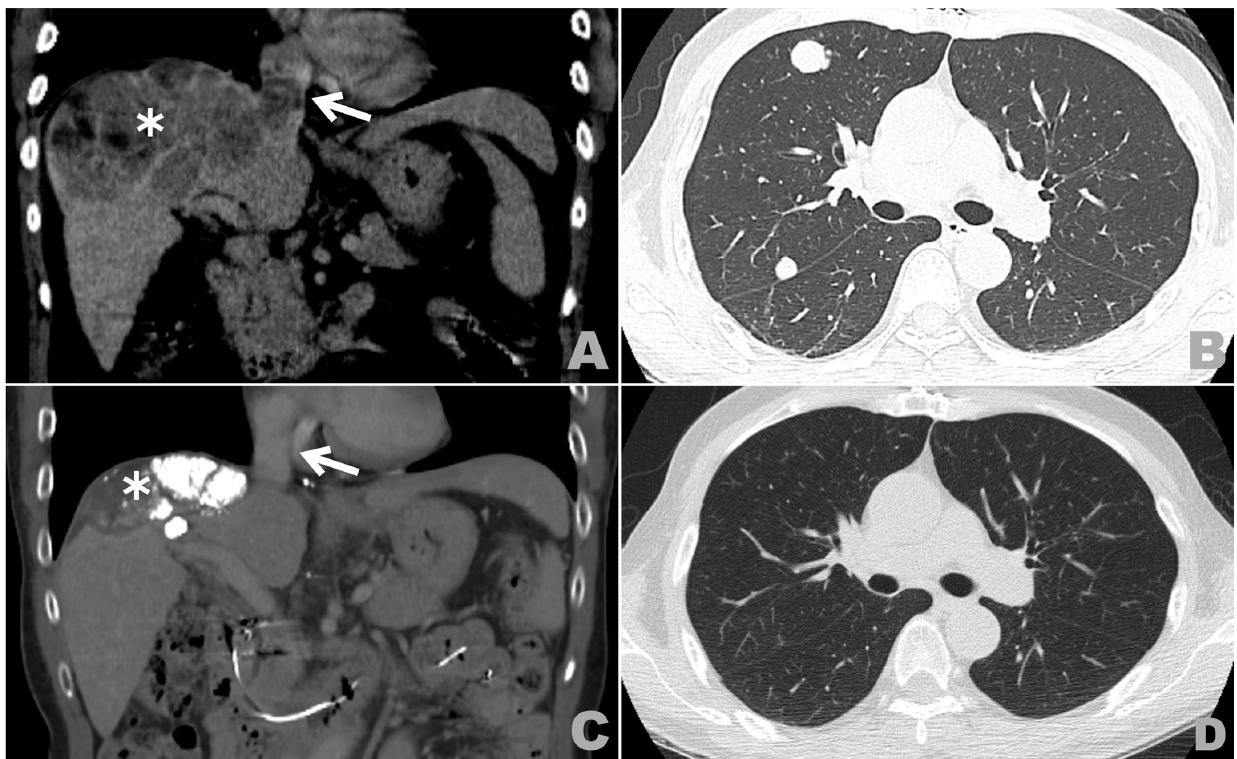
Figure 1. Key imaging studies with different treatment modalities: ( A ) contrast-enhanced CT of upper abdomen with coronal reconstruction at initial diagnosis shows a huge liver tumor (white asterisk, ∗ ) with tumor thrombi (white arrow) in inferior vena cava (IVC) and right atrium (RA). ( B ) Chest CT after hepatic artery infusion chemotherapy (HAIC) and drug-eluting bead transarterial chemoembolization (DEB-TACE) shows progressive metastatic lung nodules. ( C ) Follow-up contrast-enhanced CT of upper abdomen with coronal reconstruction after multimodal treatment shows tumor shrinkage with cystic necrosis and lipiodol retention (white asterisk, ∗ ) and resolution of previous RA and IVC tumor thrombi (white arrow). ( D ) Follow-up chest CT after 8 cycles of nivolumab shows clear bilateral lung fields without metastatic lung nodules.